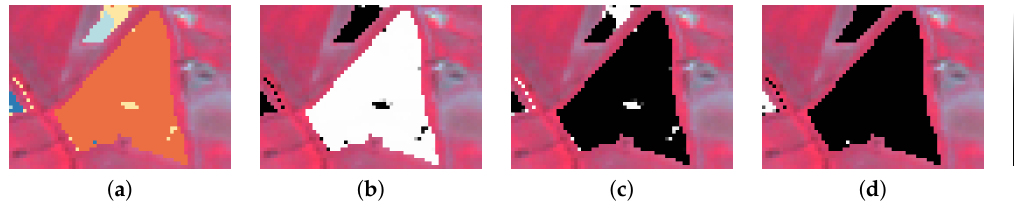
Figure 6. Grassland clustered with an initial clustering of the landscape into 8 clusters. ( a ) Hard assignment of the pixels. One color corresponds to one cluster (orange, yellow, blue). ( b – d ) Soft assignment of the pixels. The grey-scaled color corresponds to the assignment probability π ick to cluster ( b ) orange, ( c ) yellow and ( d )